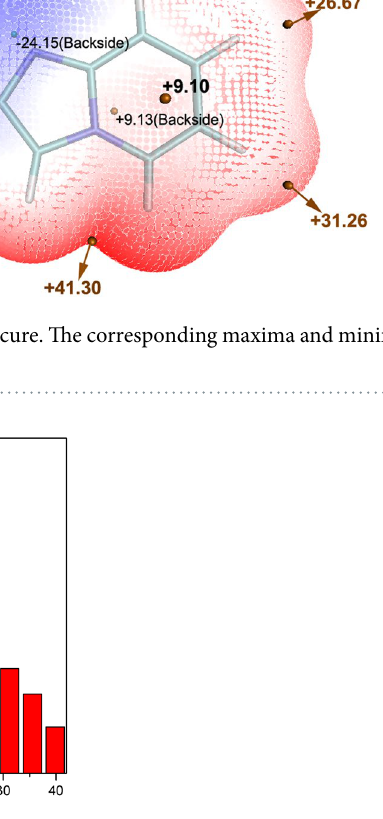
8 Scientific RepoRts | 7: 1574 | DOI:10.1038/s41598-017-01780-7